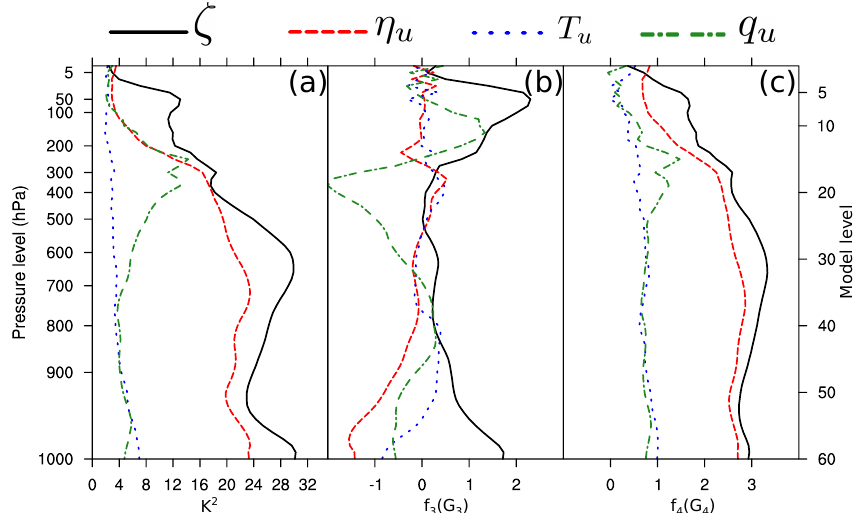
Figure 9. Vertical profiles of (a) K 2 , (b) transformed skewness f 3 (G 3 ) , and (c) transformed kurtosis f 4 (G 4 ) . For each level, values are aver- aged over the horizontal domain. Profiles are computed from the 90-member ensemble of AROME-France 3h forecasts valid at 03:00UTC on 4 November 2011. Profiles in (a) , (b) , and (c) are given for four control variables: ζ , η u , T u , and q u .